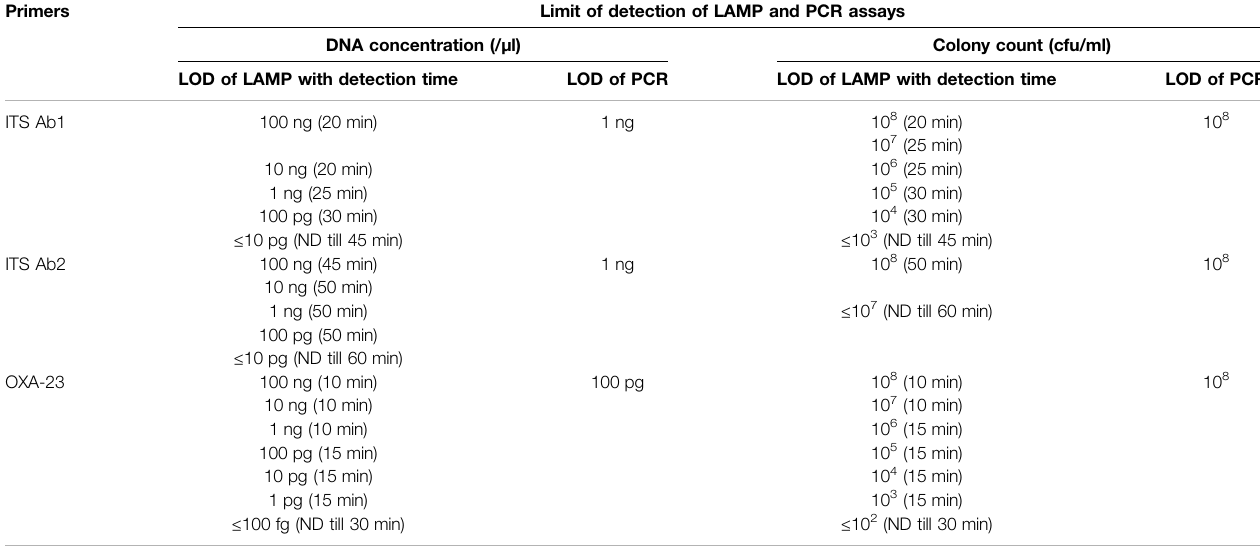
TABLE 3 | Limit of detection of LAMP and PCR assays from different DNA concentrations and colony counts using ITS (Ab1 and Ab2) and OXA-23 primers for detection of clinically signi fi cant members of the ACB complex and carbapenem resistance, respectively. Primers Limit of detection of LAMP and PCR